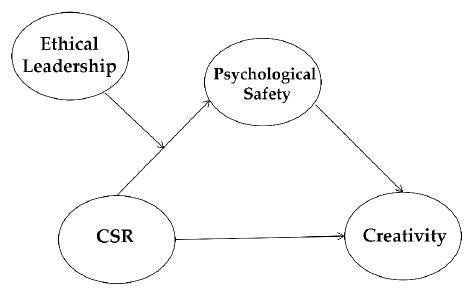
Figure 2. Alternative structural model.